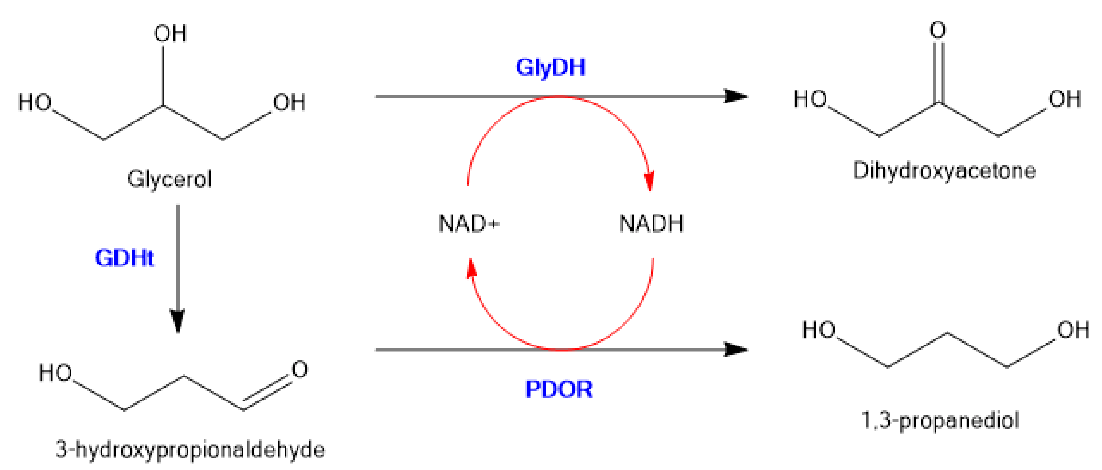
Figure 8. Three enzyme immobilized system to convert Glycerol to 1,3-propanediol with in situ co-factor recycling.